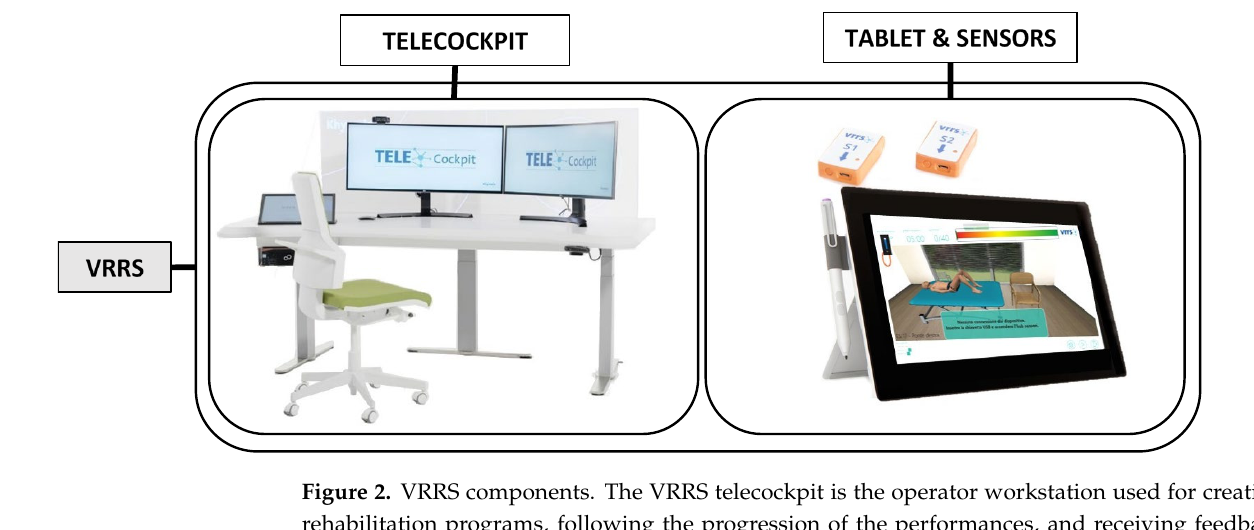
Figure 2. VRRS components. The VRRS telecockpit is the operator workstation used for creating rehabilitation programs, following the progression of the performances, and receiving feedback from the user via live videocalls and therapeutic sessions. The VRRS tablet provides a home virtual rehabilitation program to patients and works in tandem with wearable sensors. Table 1. Home rehabilitation regimen after total hip arthroplasty. Control group I and VRRS group (V), respectively, received interventions through an illustrated booklet and the telerehabilitation system. “AMAYC“: “as much as you can”; 40 rep/5 min: 40 repetitions within 5 min; a.s.: after surgery; n/a: not applicable; VR: virtual reality